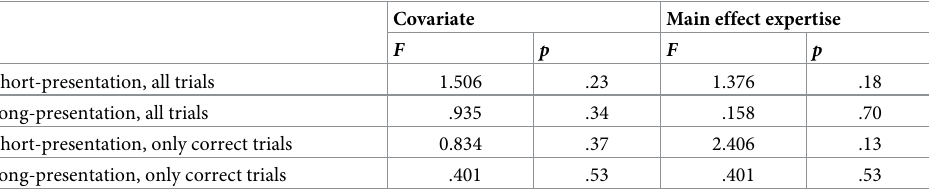
Table 2. F - and p -values for the ANCOVAs.